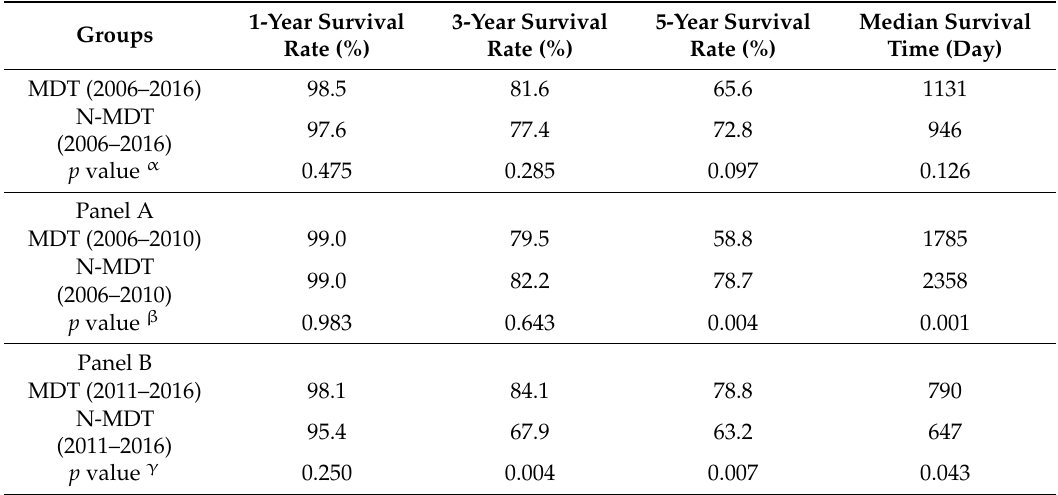
Table 4. The e ff ects of MDT group and N-MDT group after PSM (patients from 2006 to 2016, n =